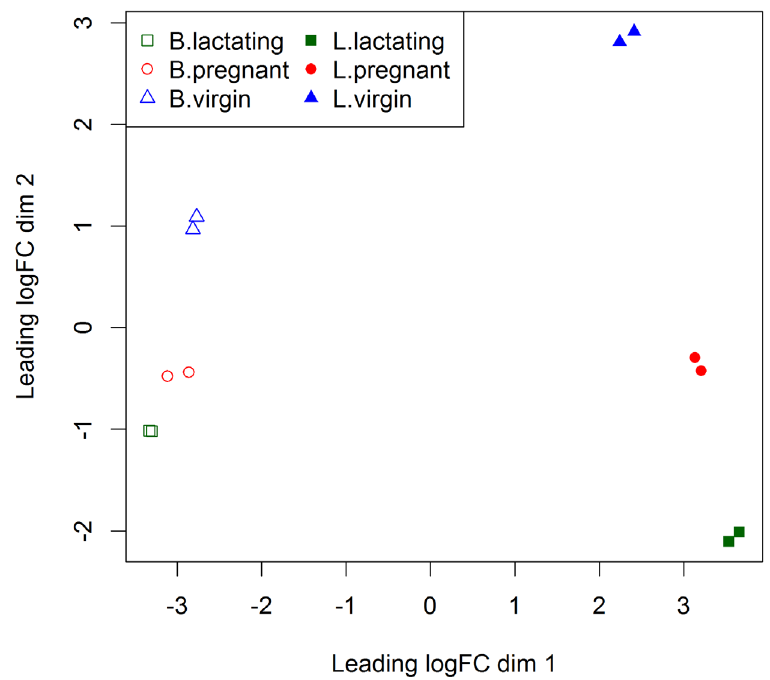
Figure 1. The MDS plot of the data set. Samples are separated by the cell type in the first dimension, and by the mouse status in the second